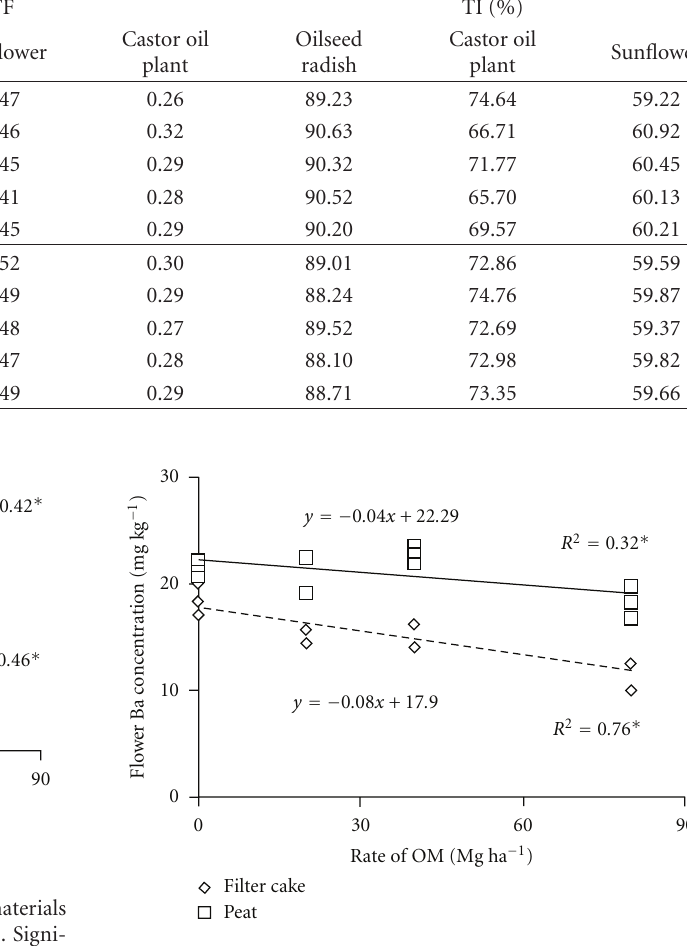
ff ect of increasing concentrations of organic materials on Ba concentration in the flowers of sunflowers (d.w.). Significant at P < 0 .